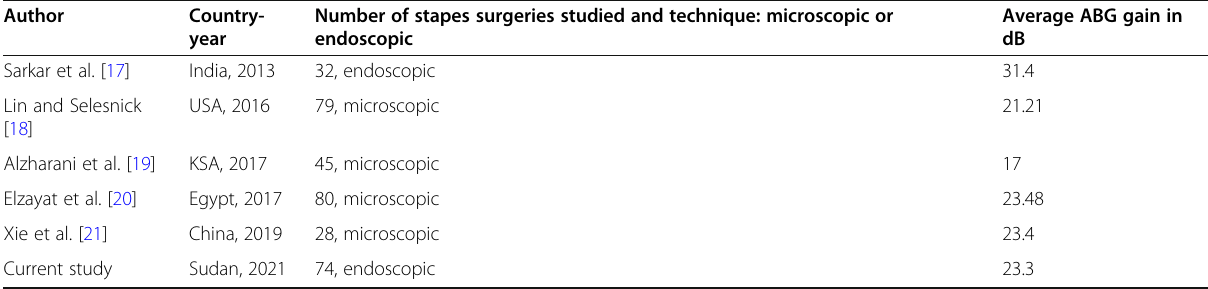
Table 3 Mean air bone gap (ABG) gain after stapedotomy in different